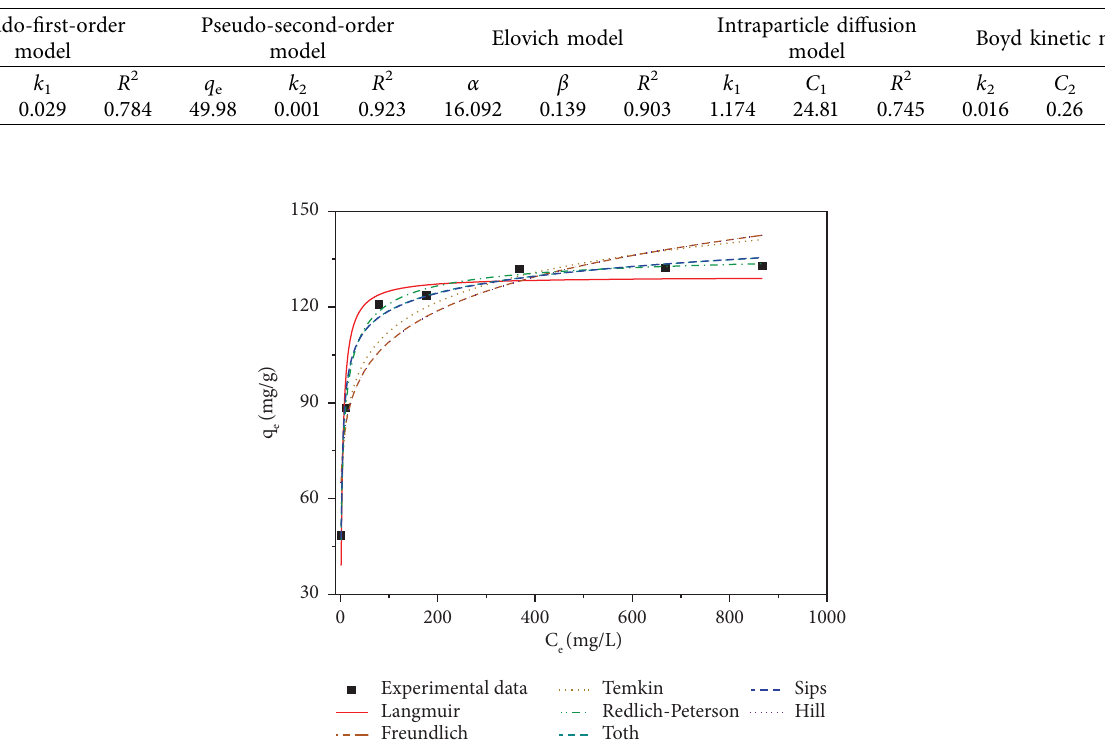
Table 2: Te kinetic model ftting